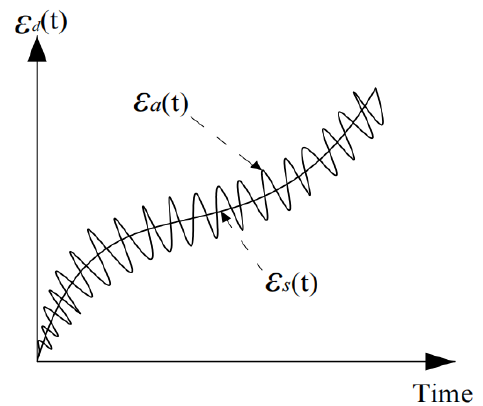
Figure 5. Total dynamic strain-time curve of clay.